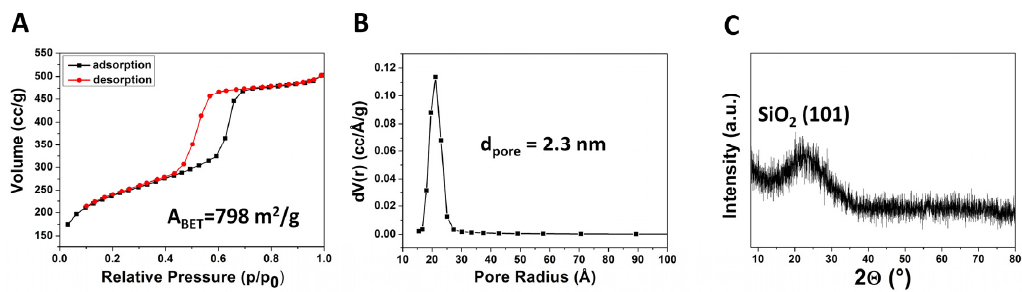
Figure 4 . ( A ) BET isotherm and ( B ) corresponding pore diameter distribution as well as ( C ) powder XRD pattern of pure SBA ‐ 15 silica support.